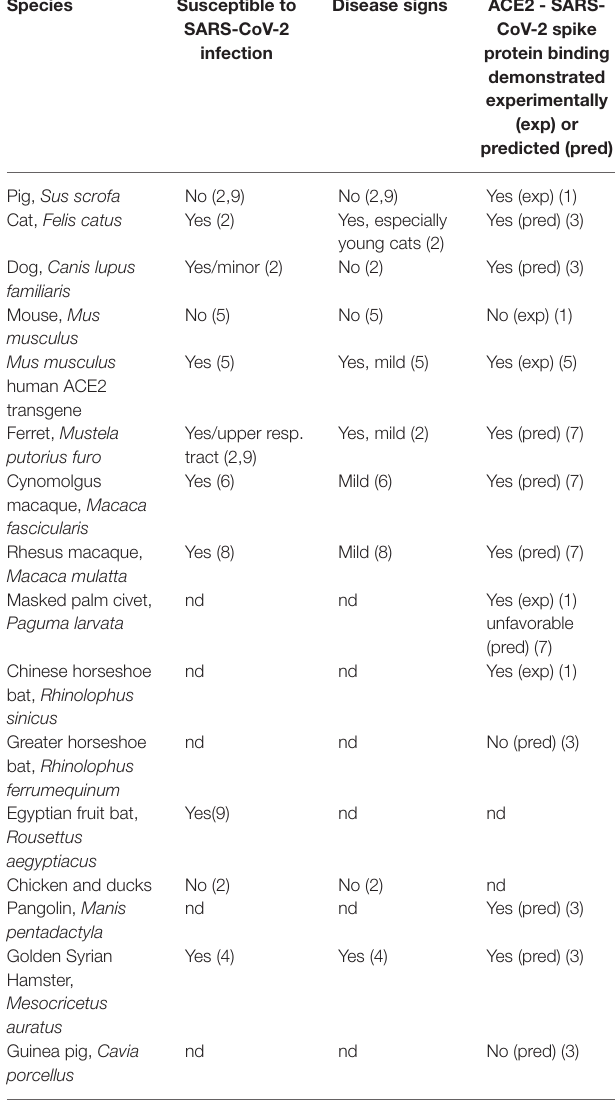
TABLE 1 | Susceptibility to SARS-CoV-2 infection, disease signs, and ability of ACE2 to bind SARS-CoV-2 spike protein as predicted (based on protein sequence) or shown experimentally for various